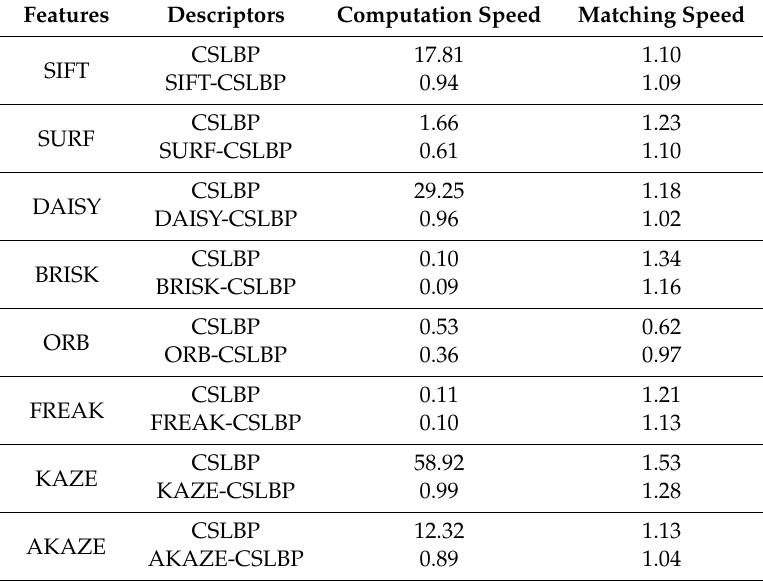
Table 11. The ratios of the CSLBP and combined descriptors to the original descriptors in computational and matching